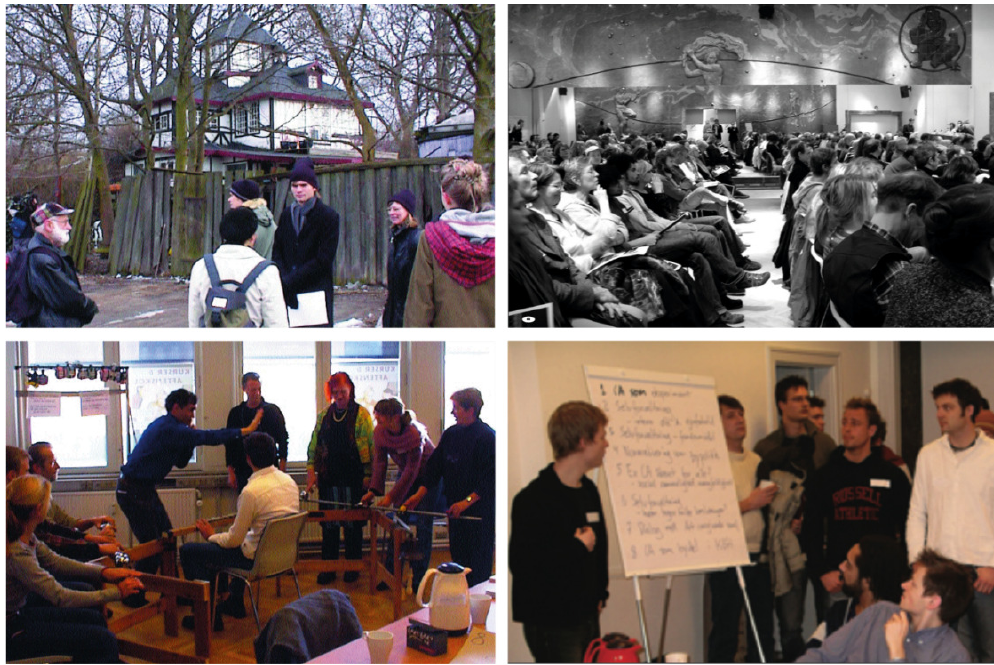
Figure 2. Elements of the Christiania conference. From left to right, top to bottom: Guided tour, trial, “jury deliberation,” and “verdict.” Source: Courtesy of